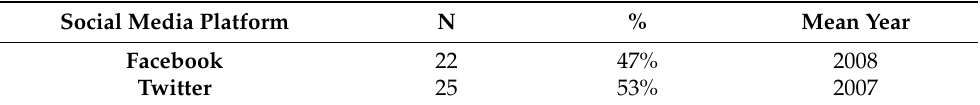
Table 2. Facebook and Twitter popularity in the